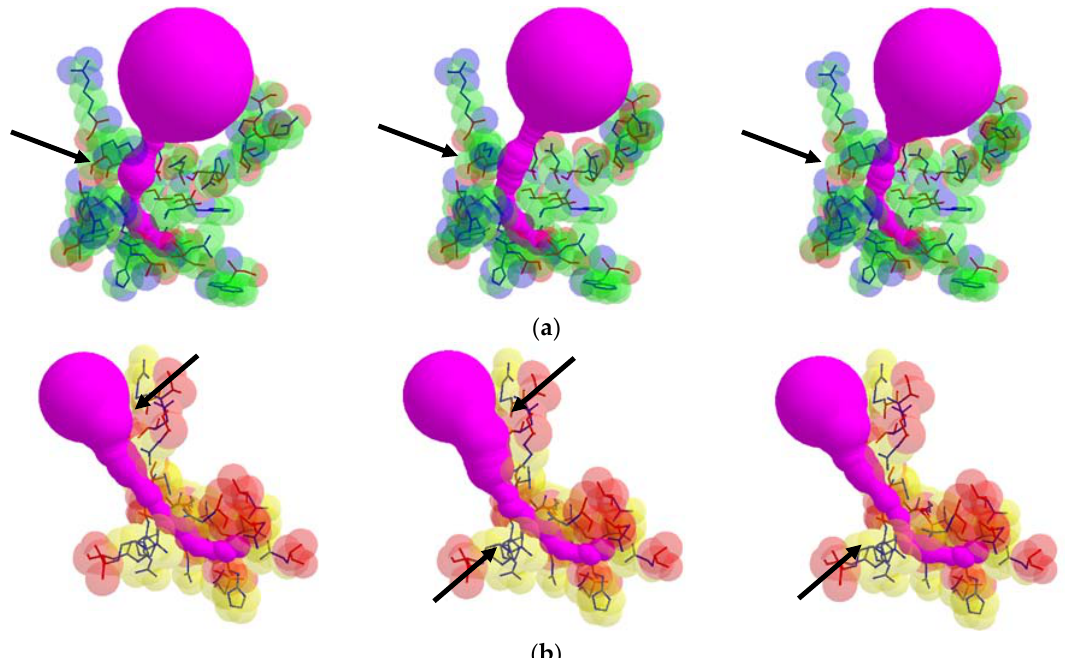
Figure 6. Tunnel shape changes with respect to different valid rotamer conformations, where arrows indicate changes of the tunnel shape: ( a ) tunnel Id. 138 of PDB Id. 1EA1 and ( b ) tunnel Id. 140 of PDB Id. 1DDZ.